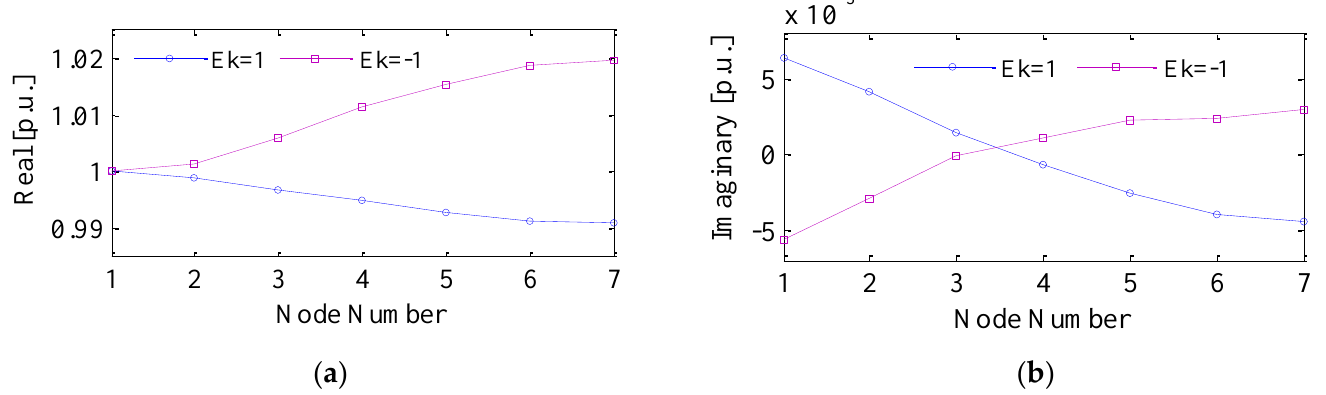
Figure 3. Bus voltage phasors with ( a ) real part and ( b ) imaginary part at the bound values of ε K . It can be clearly seen that the real and imaginary parts change with different tenden- cies at different bound values of 𝜀 . The different values of 𝜀 represent the different ranges of parameter changes in the model uncertainties. Figure 4. Cont ] u . .